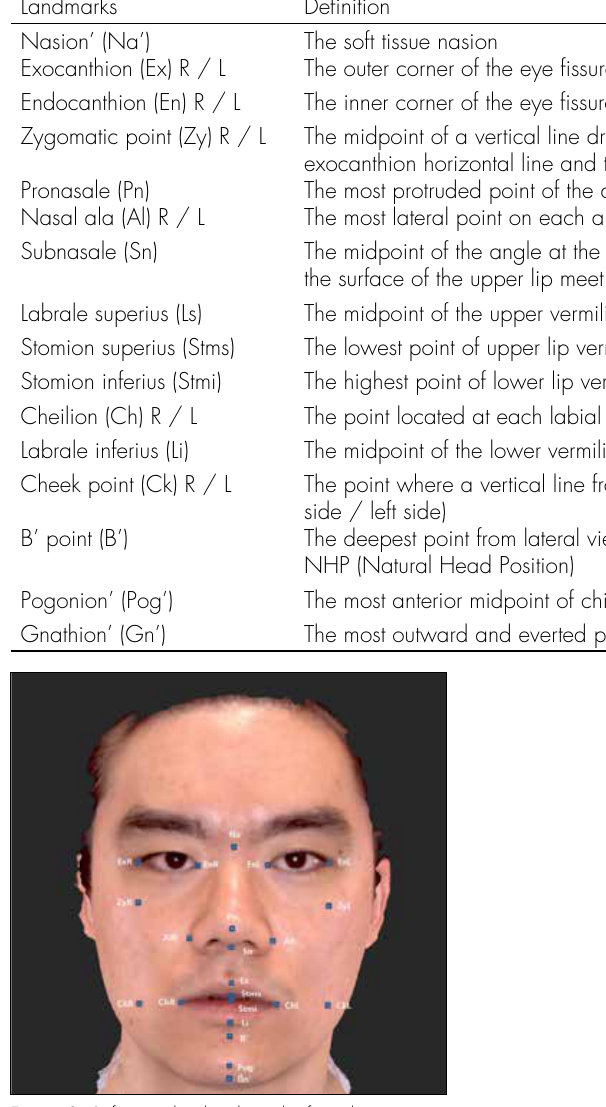
Figure 2. Soft tissue landmarks in the frontal view: Nasion’ (Na’); Exocanthion (Ex R/L); Endocanthion (En R/L); Zygomatic point (Zy R/L); Pronasale (Pn); Nasal ala (Al R/L); Subnasale (Sn); Labrale superius (Ls); Stomion superius (Stms); Stomion inferius (Stmi); Cheilion (Ch R/L); Labrale inferius (Li); Cheek point (Ck R/L); B’ point (B’); Pogonion’ (Pog’); Gnathion’